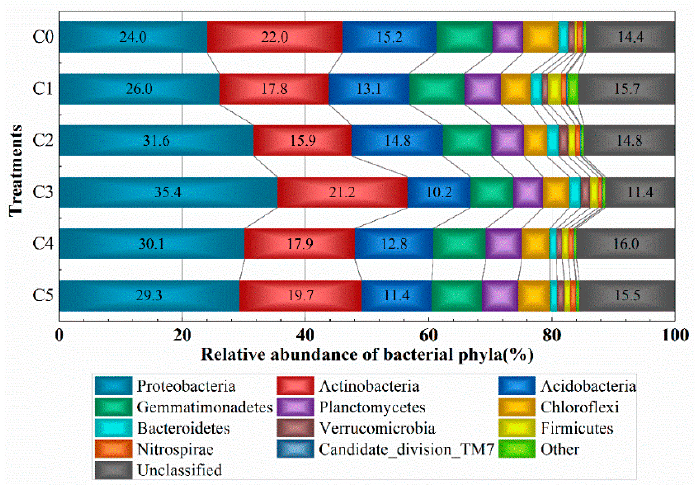
Figure 2. Relative abundance of the bacterial community at the phylum level. Phyla that compose less than 2% of the bacteria in all treatments are grouped into “Other”. Sequences that could not be classified into any known group were assigned as “Unclassified”.